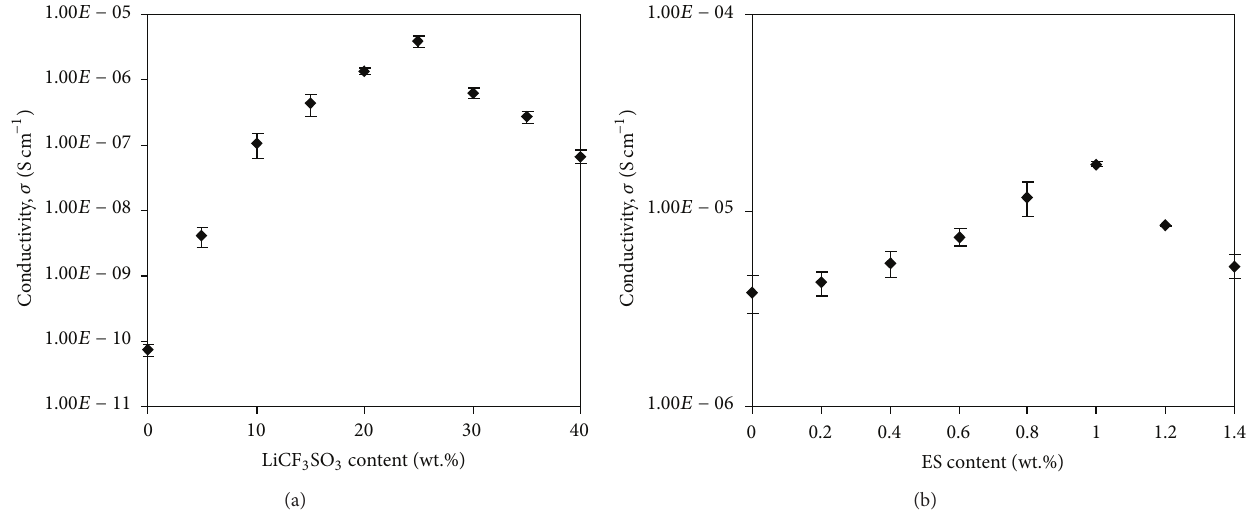
Figure 6: Room temperature conductivity as a function of (a) LiCF 3 SO 3 content and (b) ES